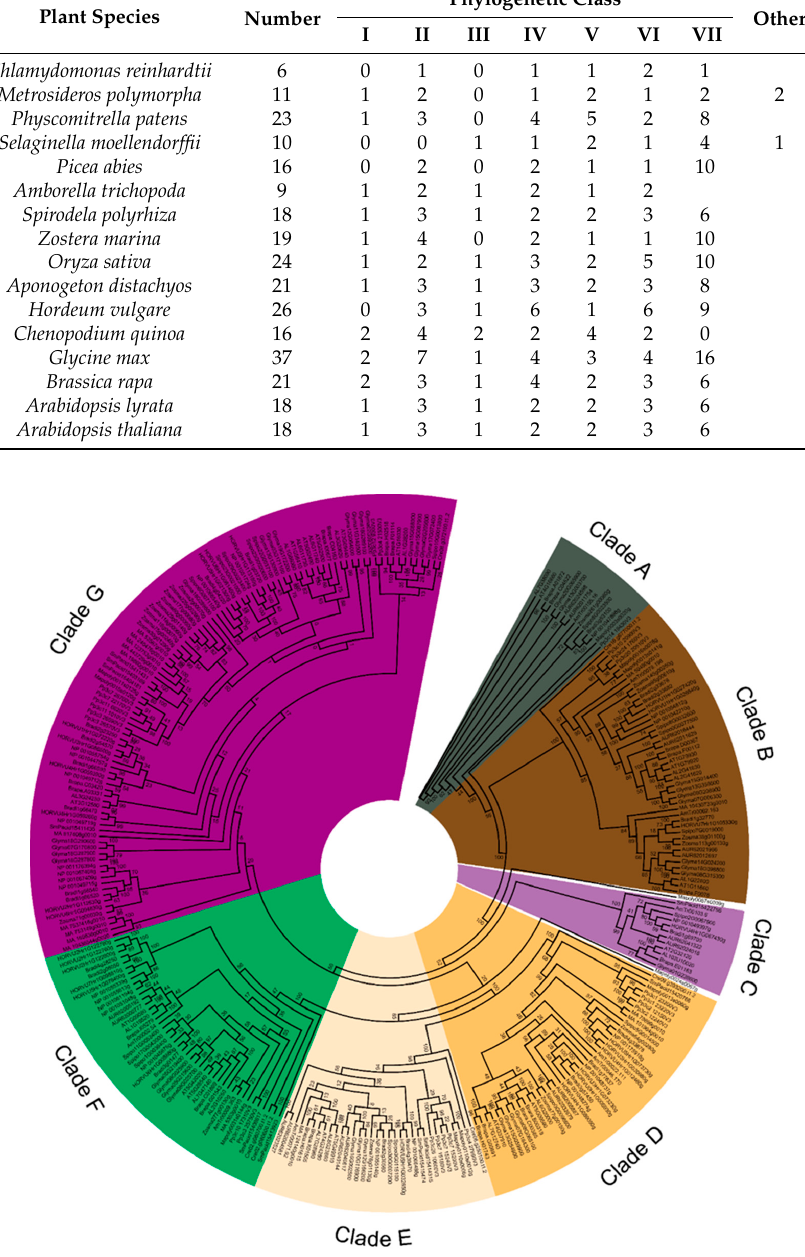
Figure 2. Phylogenetic tree of HSP70s in different plant species. Based on the total identified 293 HSP70 homologs in 16 plant species, an unrooted phylogenetic tree was calculated with the Maximum-Likelihood method, using JTT modeling with gamma-distributed rates and 1000 bootstrap replications. Bootstrap values are indicated at the base of each clade. The color region is associated with seven groups of proteins, i.e., Clades A to